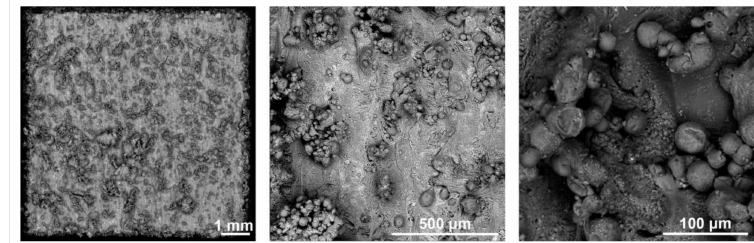
Figure 3. Surface morphology of the 3D-printed material (SEM).